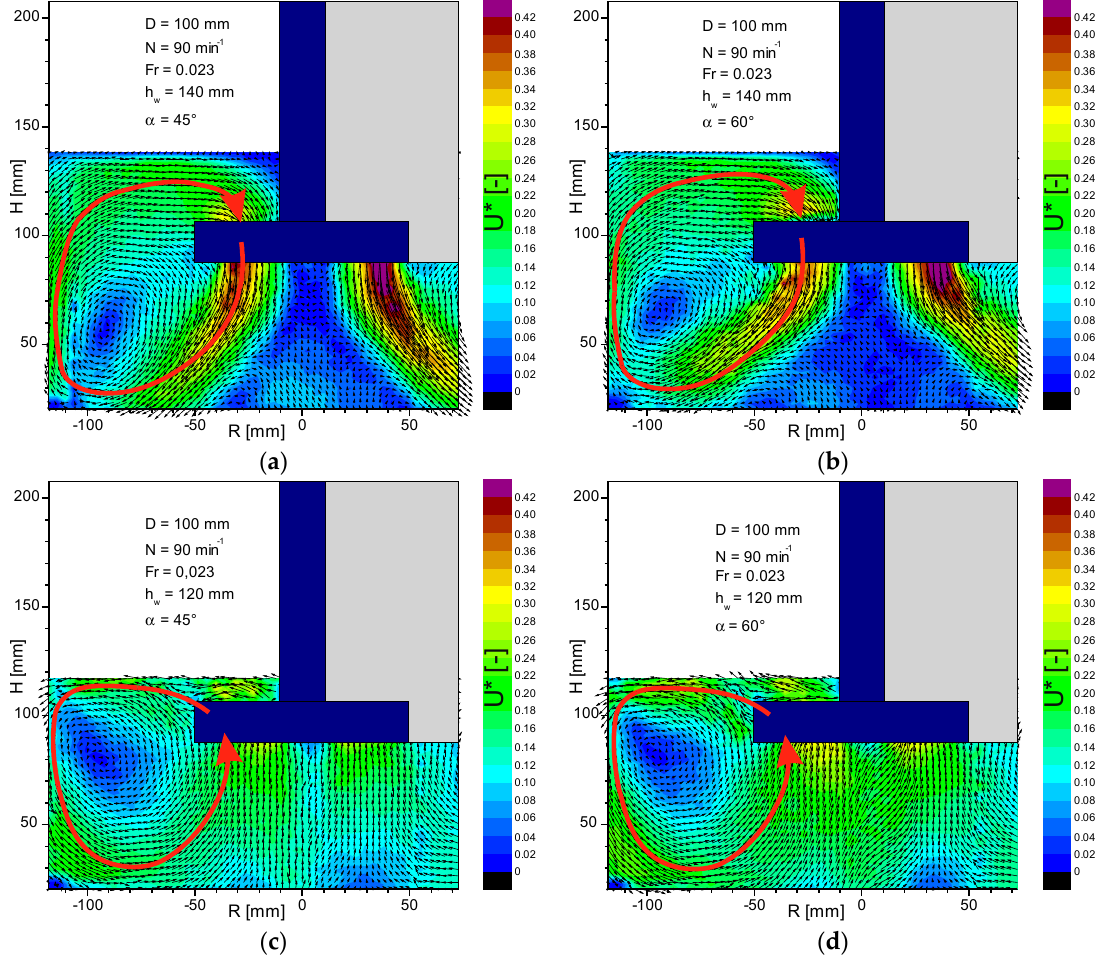
Figure 3. Liquid flow before the partition for the PBT45 and PBT60 impellers: ( a ) h w = 140 mm, α = 45°; ( b ) h w = 140 mm, α = 60°; ( c ) h w = 120 mm, α = 45°; ( d ) h w = 120 mm, α =60°.